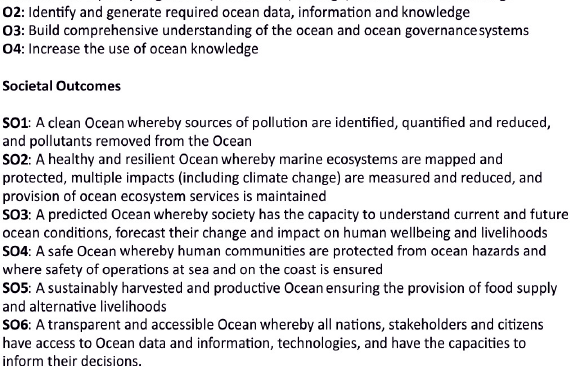
change (SO2). Existing models and maps are simplistic,